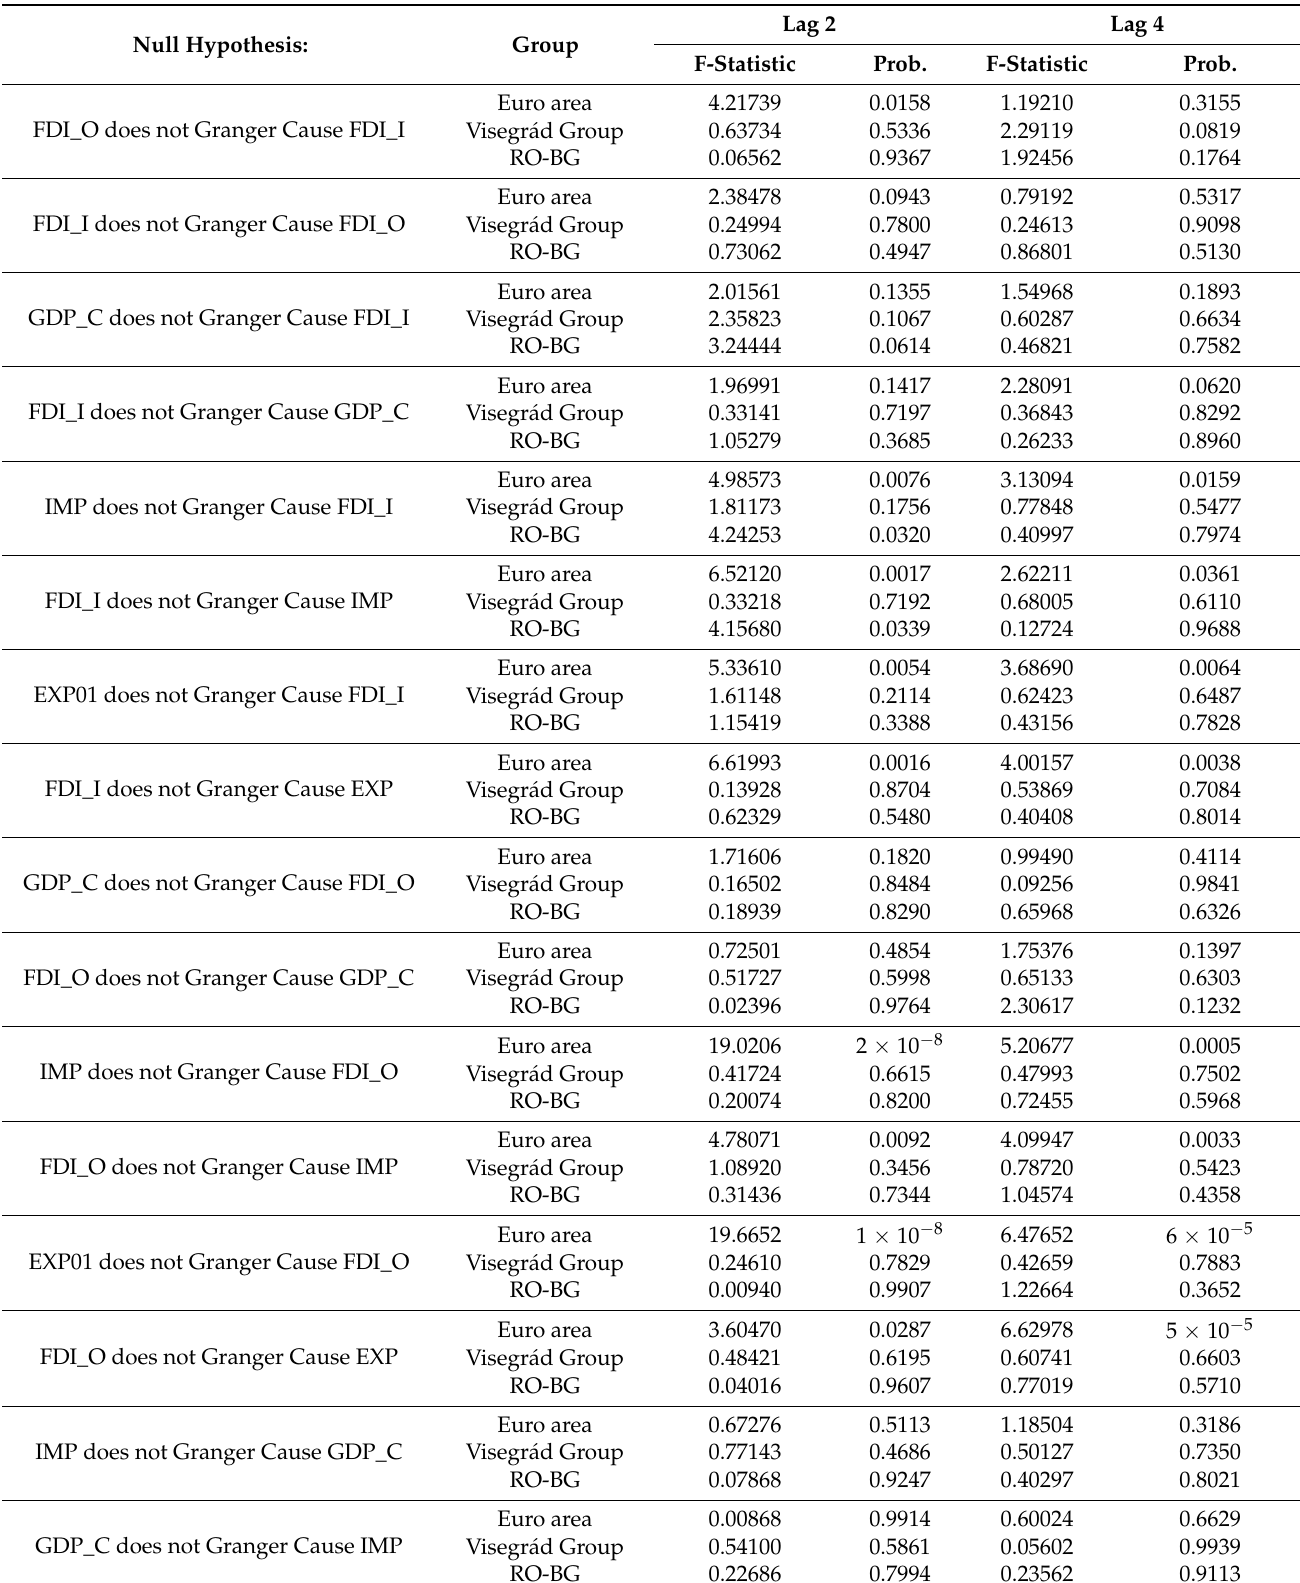
Table 3. Granger pairwise causality